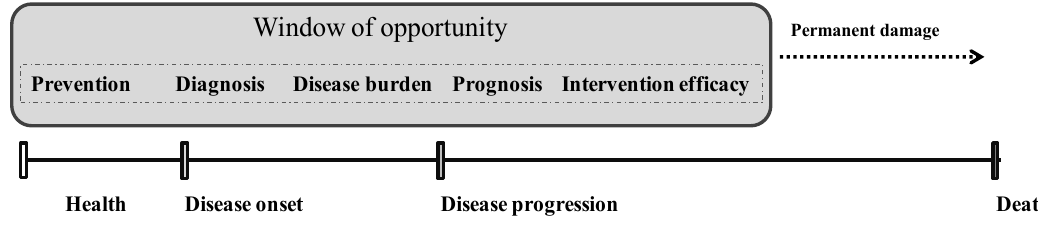
Figure 1. Use and significance of biomarkers during the onset and development of disease. Biomarkers can be used for risk estimation, diagnosis, and determination of severity and pharmacological treatment/lifestyle intervention